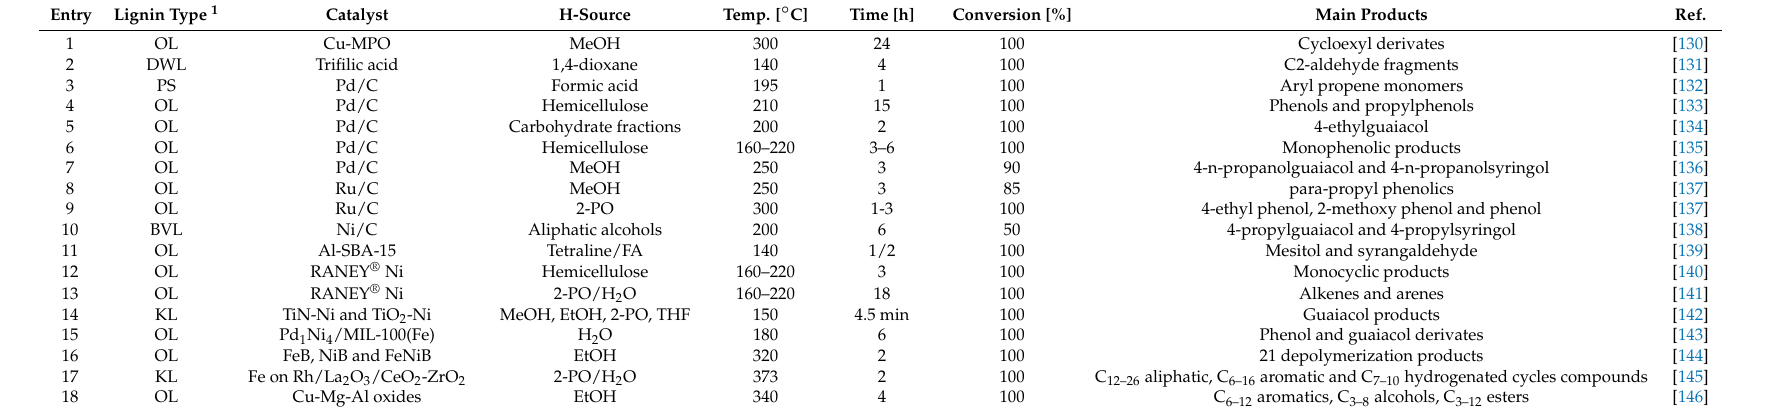
Table 7. A literature overview on the CTH of lignin promoted by heterogeneous